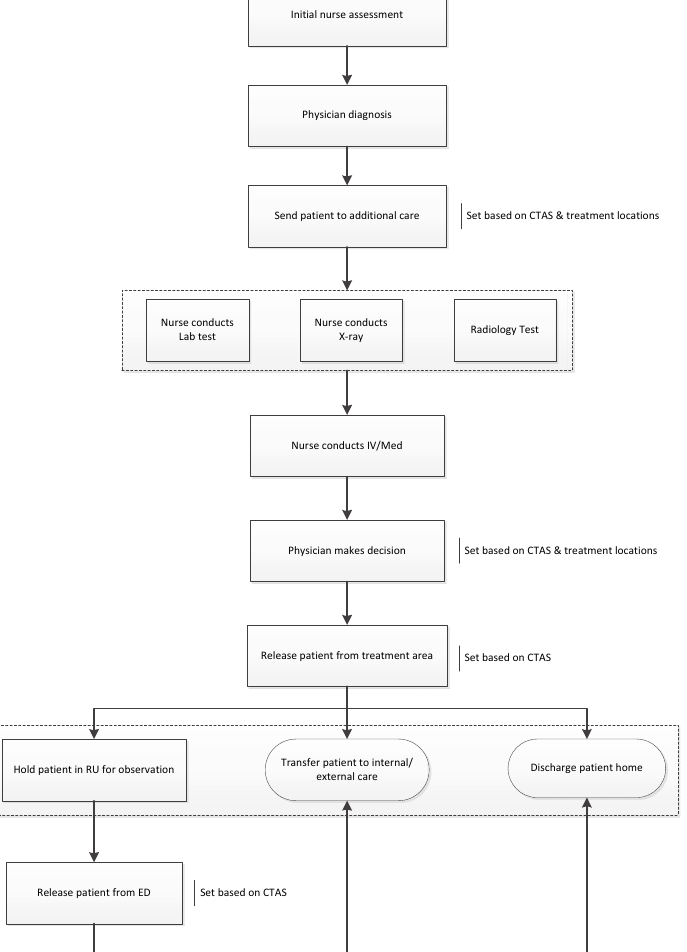
Fig. 3. Medical operation procedures for patients after being assigned into a designated treatment